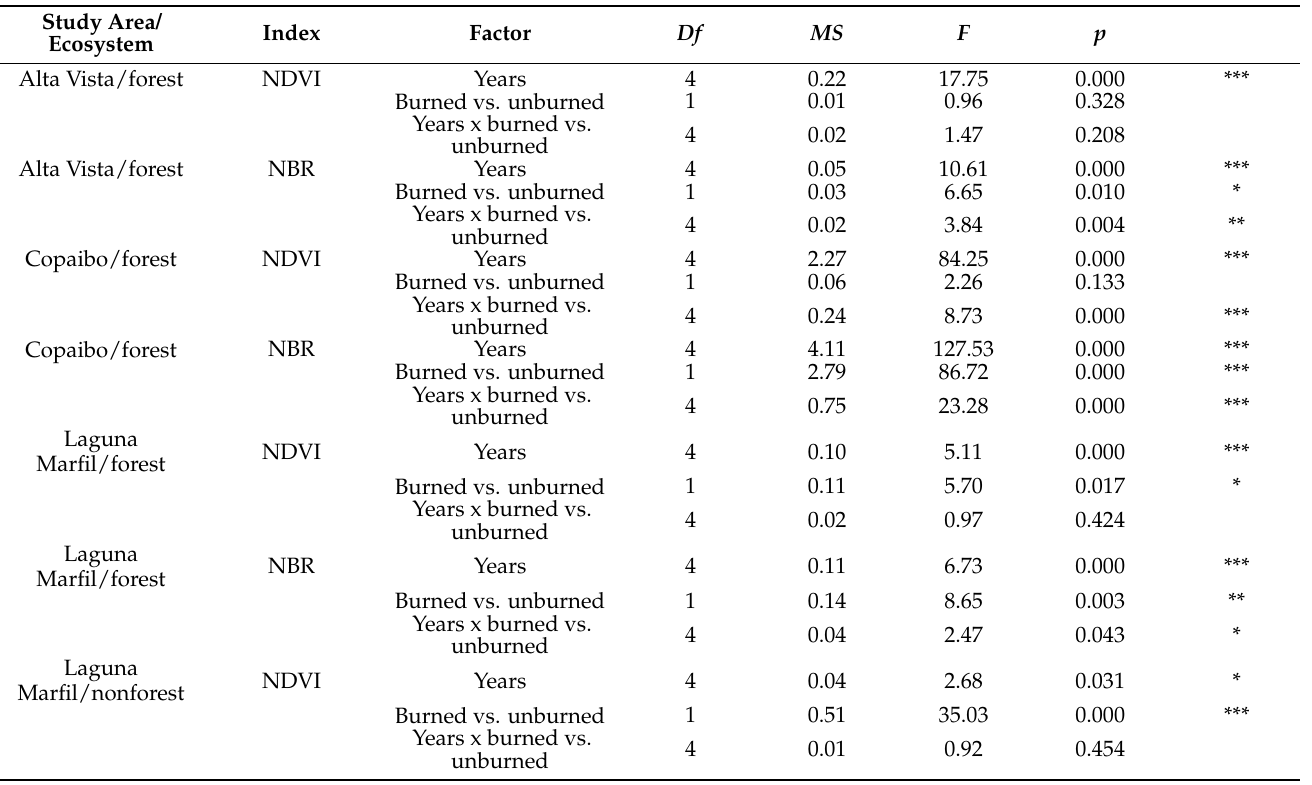
Table 5. Two-way ANOVA results on difference between NDVI and NBR spectral indices in the five years of analysis (2016–2020) in burned versus unburned areas in the four study areas of the Department of Santa Cruz. Degrees of freedom ( Df ), mean sum of squares ( MS ), F-statistic ( F ), and p -value ( p ) are the test